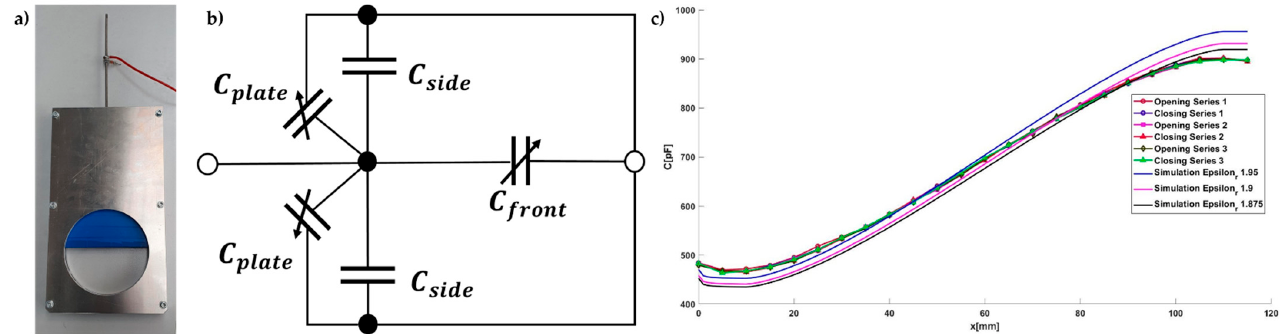
Figure 7. ( a ) Used sensory utilizable prototype valve; ( b ) model of the electrical equivalent circuit representing the capacitance of the valve; ( c ) simulation of different relative dielectric constants and measured data of the prototype; all by [10].